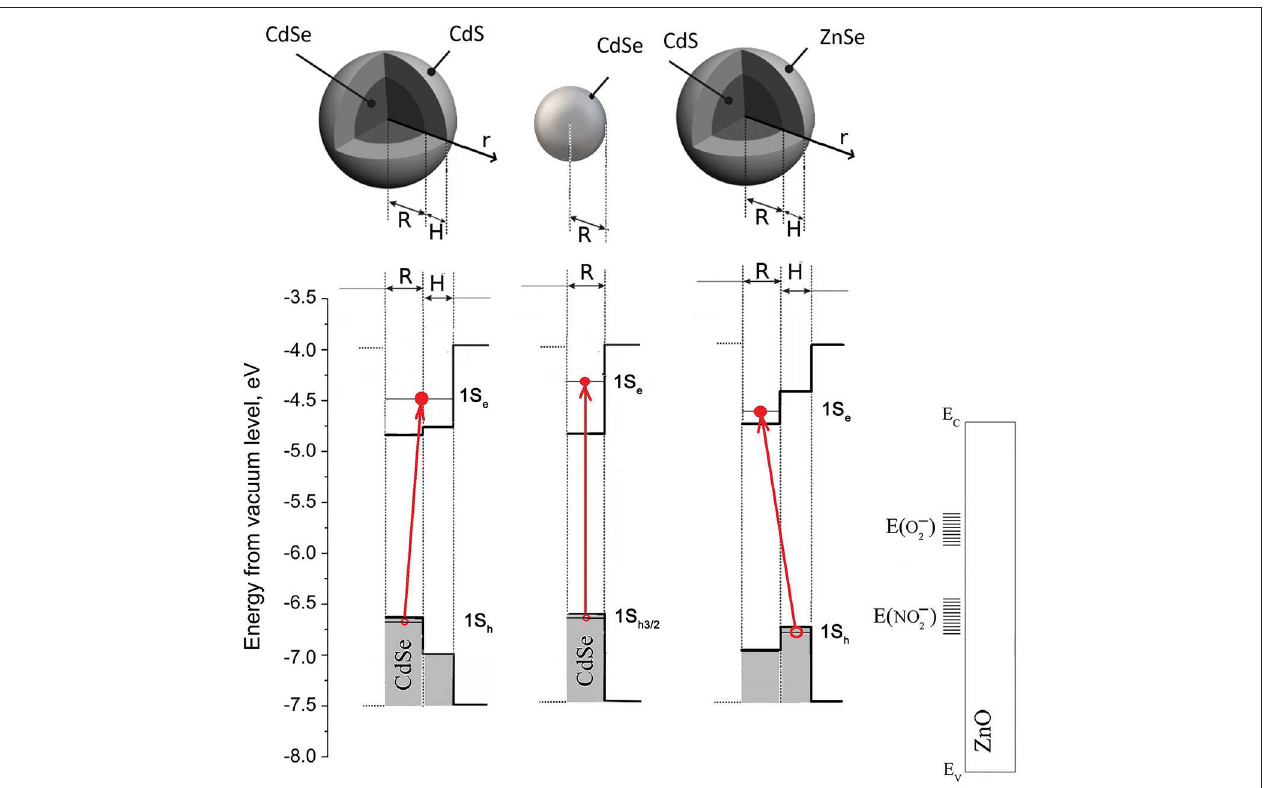
FIGURE 9 | Band diagram for ZnO/CdSe, ZnO/(CdS@CdSe), and ZnO/(ZnSe@CdS) systems. Band alignment for core-shell nanocrystals with core radius R and shell thickness H is shown. Band parameters are taken from O’Connor et al. (2012) and Yang et al. (2014). Electron-hole separation is shown by red arrows.